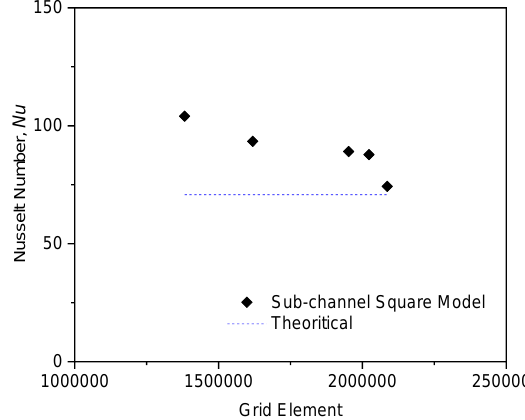
Figure 4. Nusselt number grid-independent test.